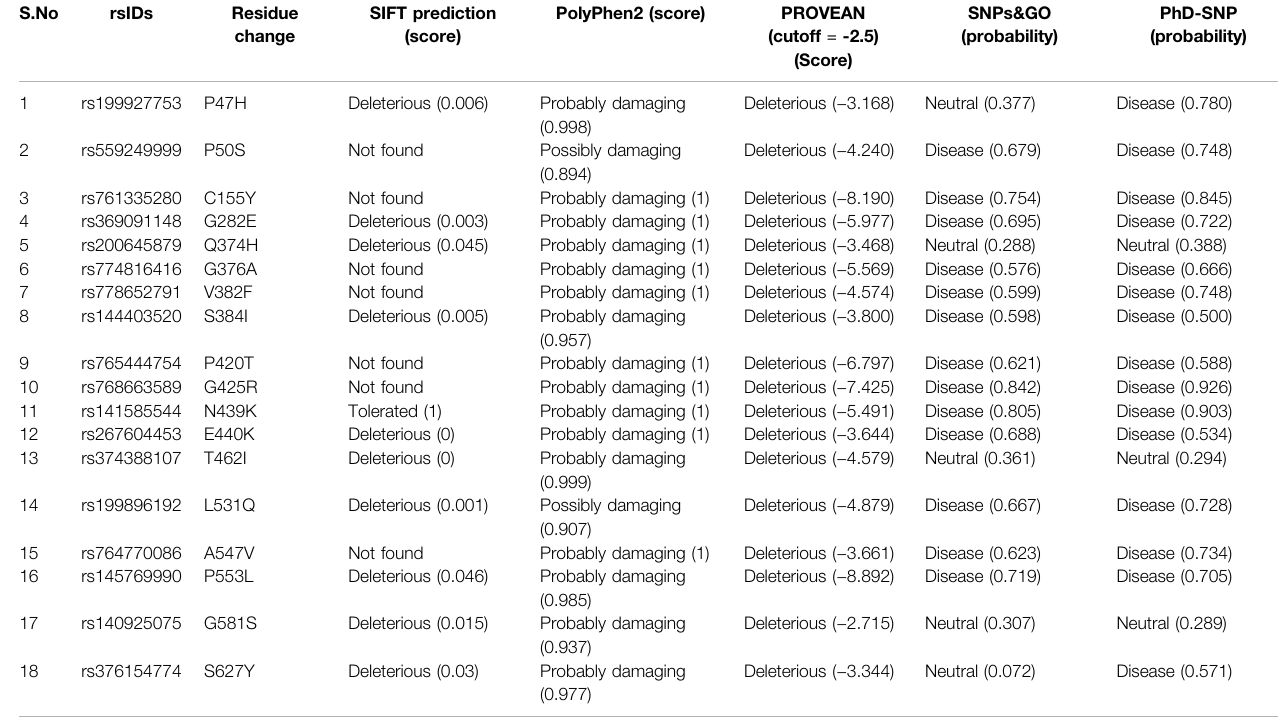
TABLE 1 | List of 18 deleterious nsSNPs in hZP2 gene, as identi fi ed by fi ve different in silico tools. The score or probability for each is mentioned within